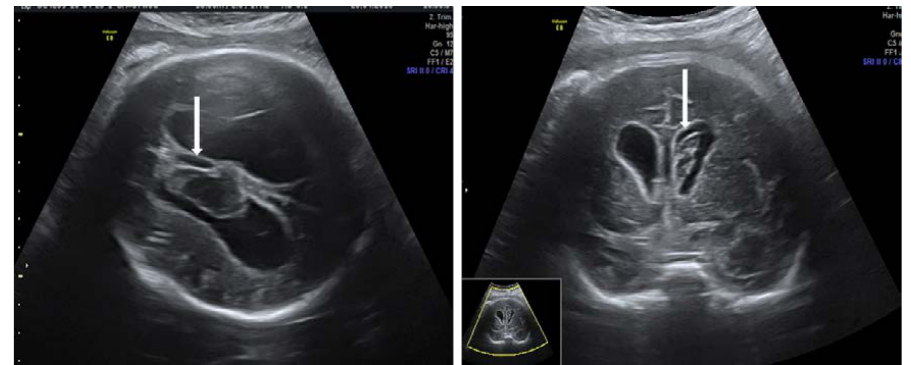
Figure 7. Fetal ventriculomegaly due to intraventricular hemorrhage (arrow) (collection of Filantropia Hospital).